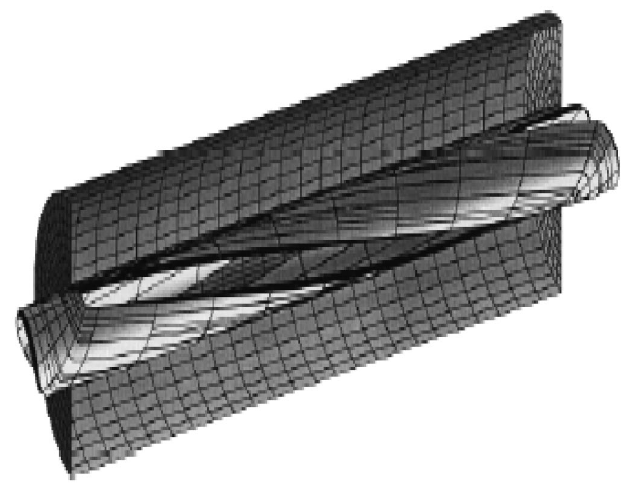
FIG. 4. Schematic representation of a helical dipole magnet showing the coil configuration and a cutaway view of the iron flux-return